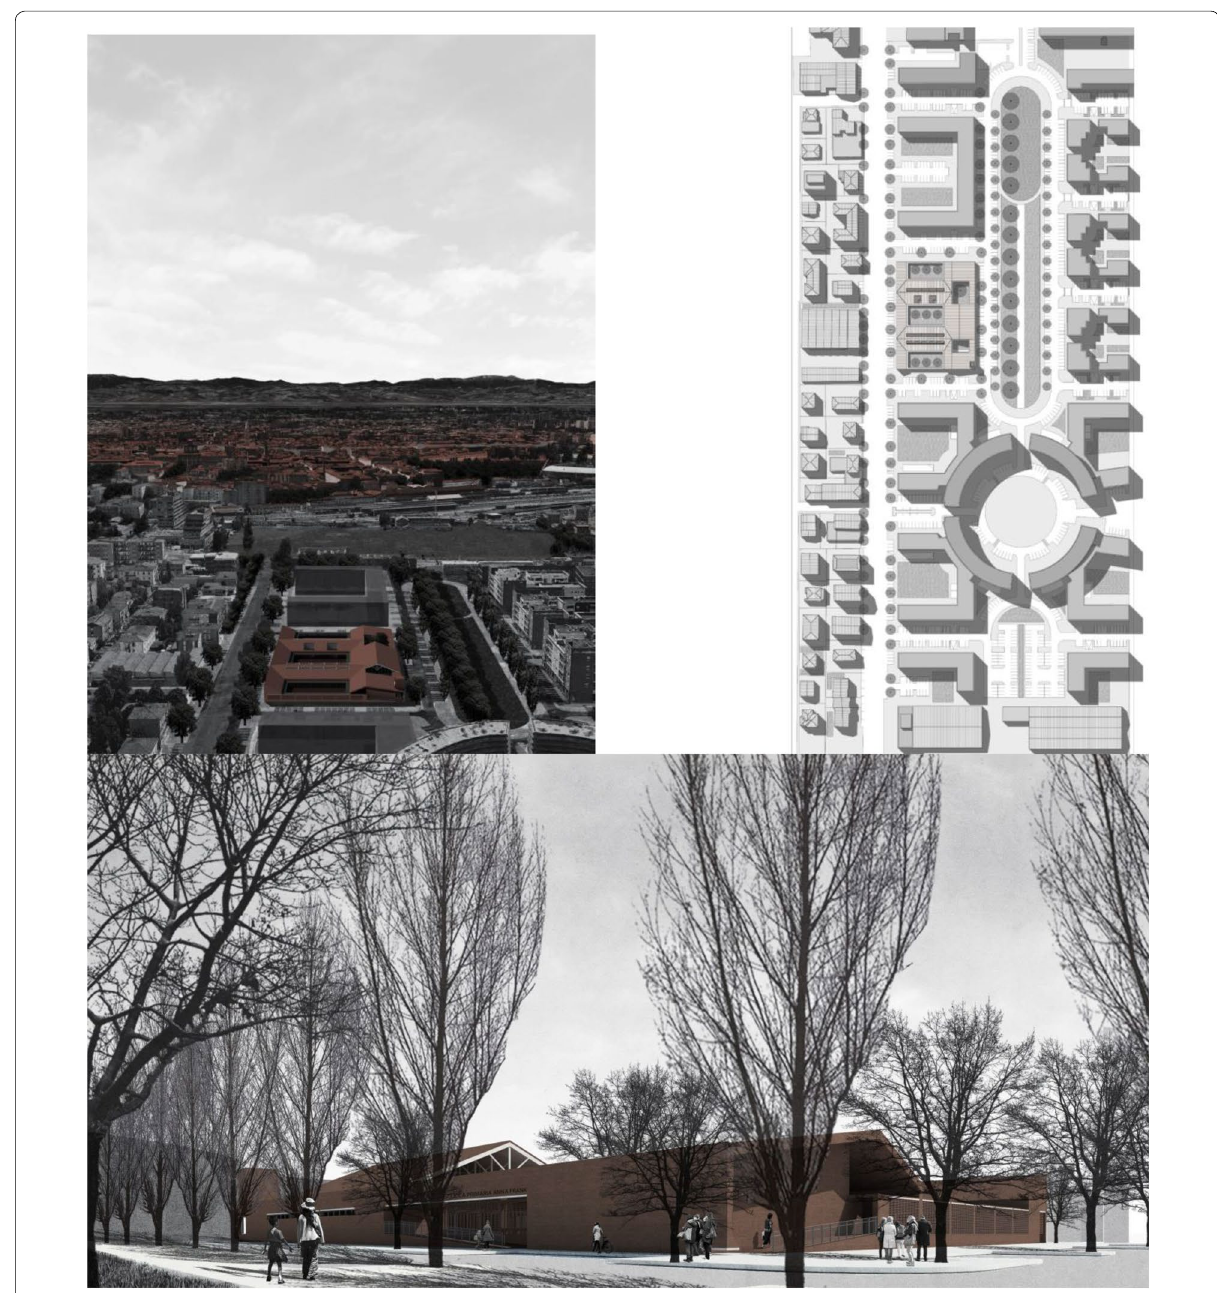
Fig. 7 The new La Madonnina school in Modena designed by L. Franciosini, C. Casadei, N. Canulli, B. Taliani de Marchio, G. Bellingeri, U. Carusi. (Copyright L. Franciosini, C. Casadei, N. Canulli, B. Taliani de Marchio, G. Bellingeri, U.